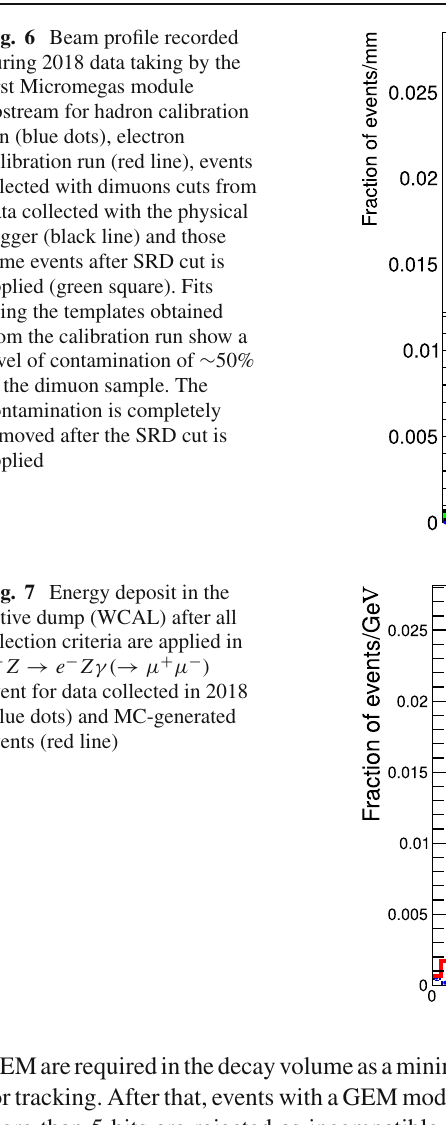
Fig. 6 Beam profile recorded during 2018 data taking by the first Micromegas module upstream for hadron calibration run (blue dots), electron calibration run (red line), events selected with dimuons cuts from data collected with the physical trigger (black line) and those same events after SRD cut is applied (green square). Fits using the templates obtained from the calibration run show a level of contamination of ∼ 50% in the dimuon sample. The contamination is completely removed after the SRD cut is applied